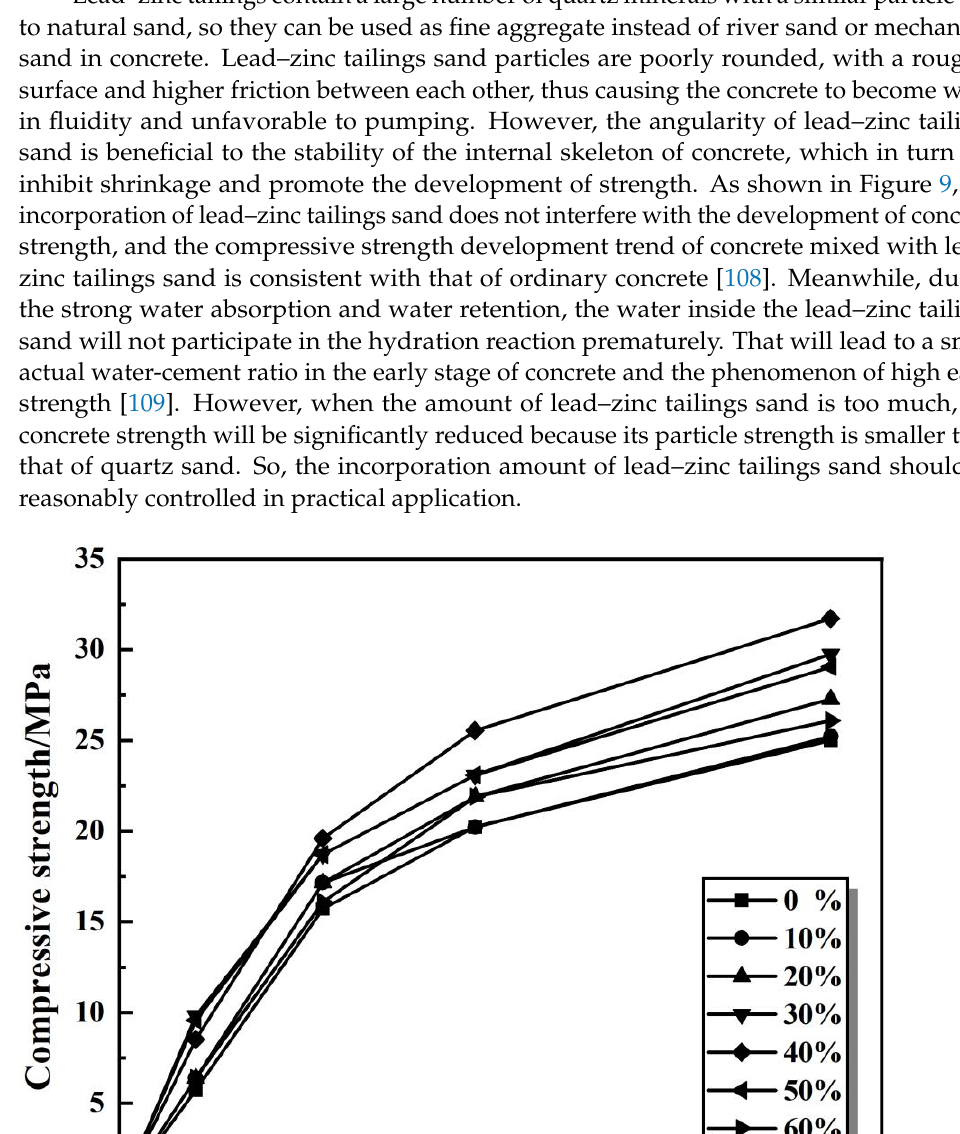
Figure 10. Relationship between γ -ray absorption coefficient of concrete and different contents of lead – zinc tailings [111].